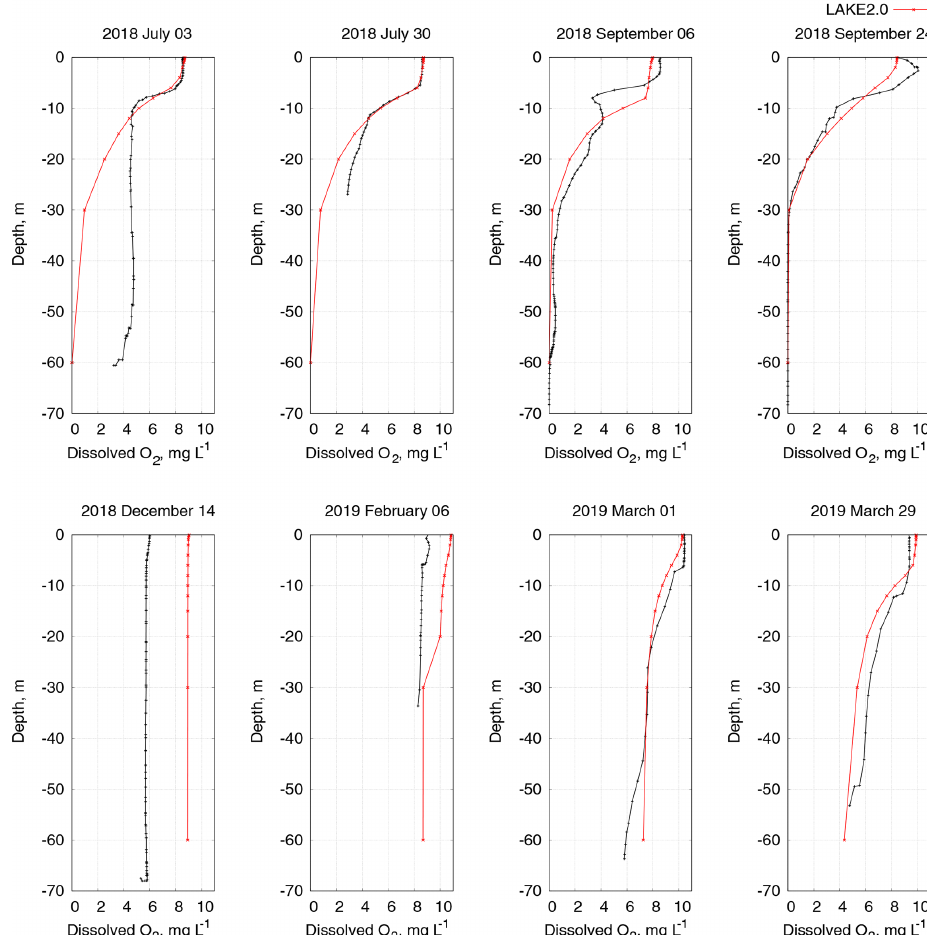
and the FLake models are presented in this work.